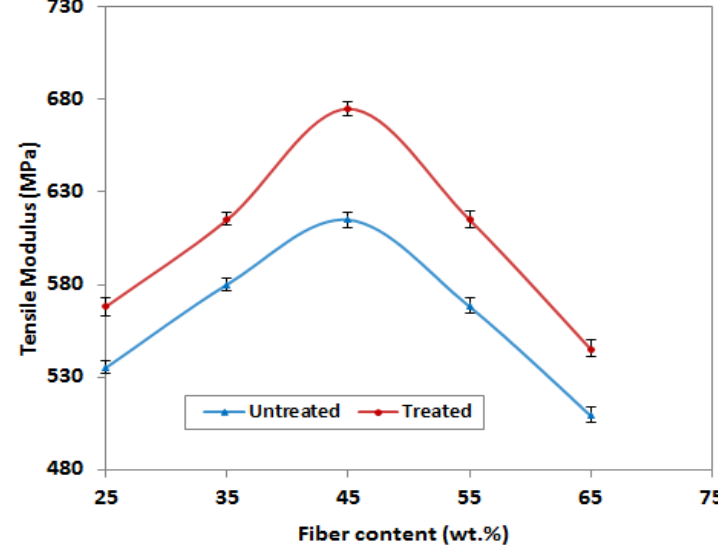
Figure 5: Comparative tensile modulus of the resultant composites with respect to fiber